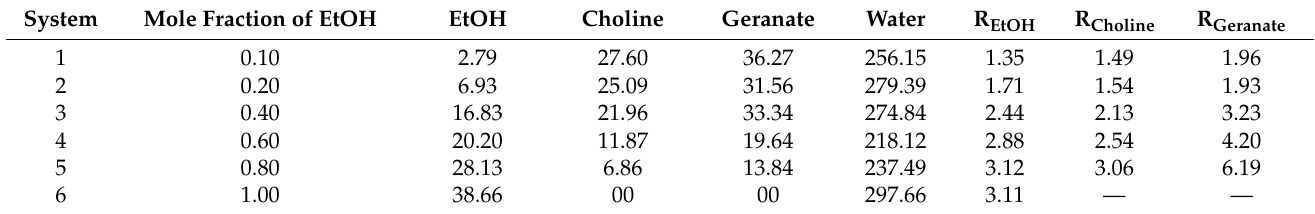
Table 2. The accumulation of choline, geranate, ethanol, and water molecules around the first solvation shell of the insulin